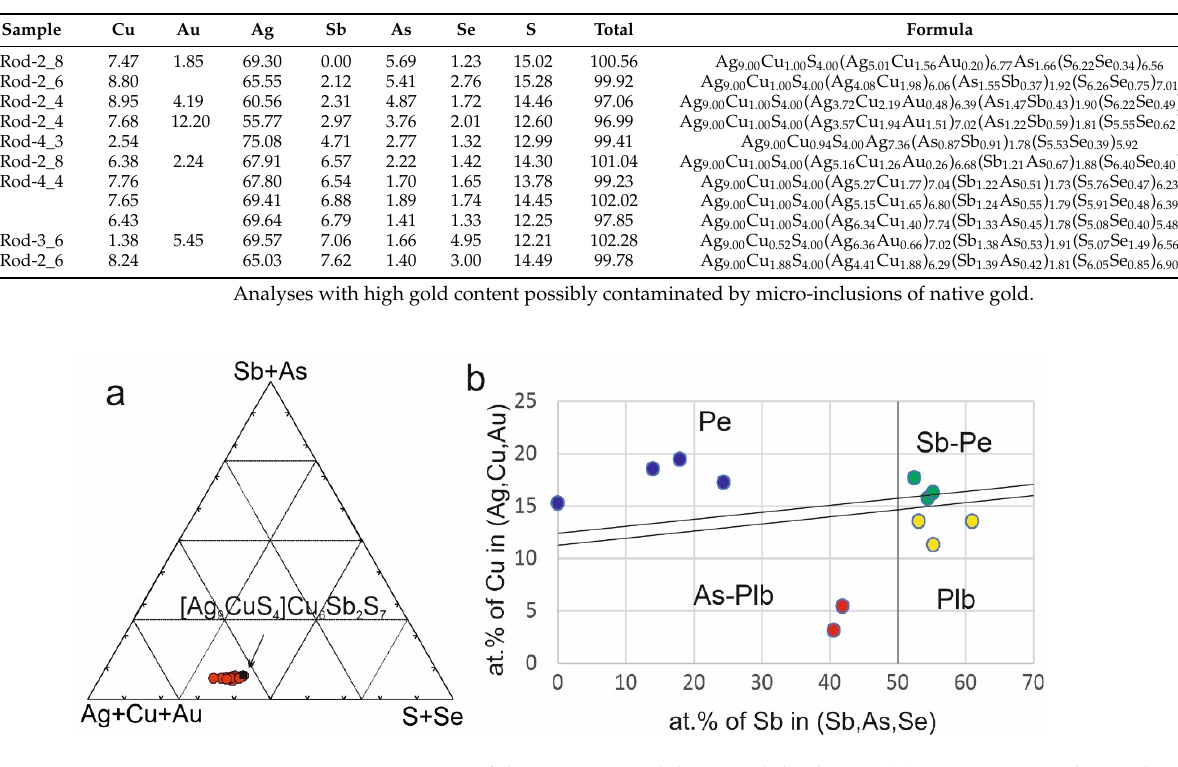
Table 6. Composition of pearceite-polybasite solid solutions (wt.%), see Figure 7a,b.